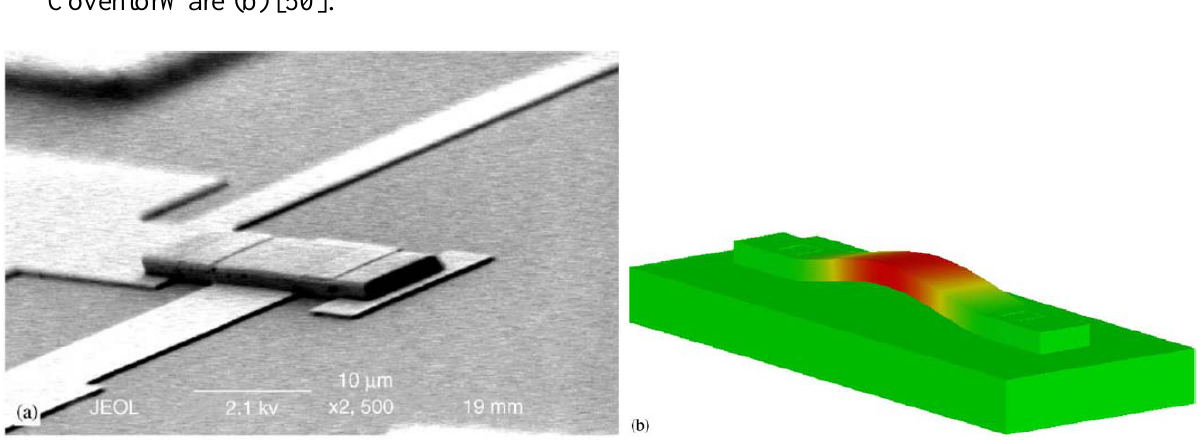
Figure 10. SEM of a microbeam resonator (a) and its 1st modal shape simulated by CoventorWare (b) [50].